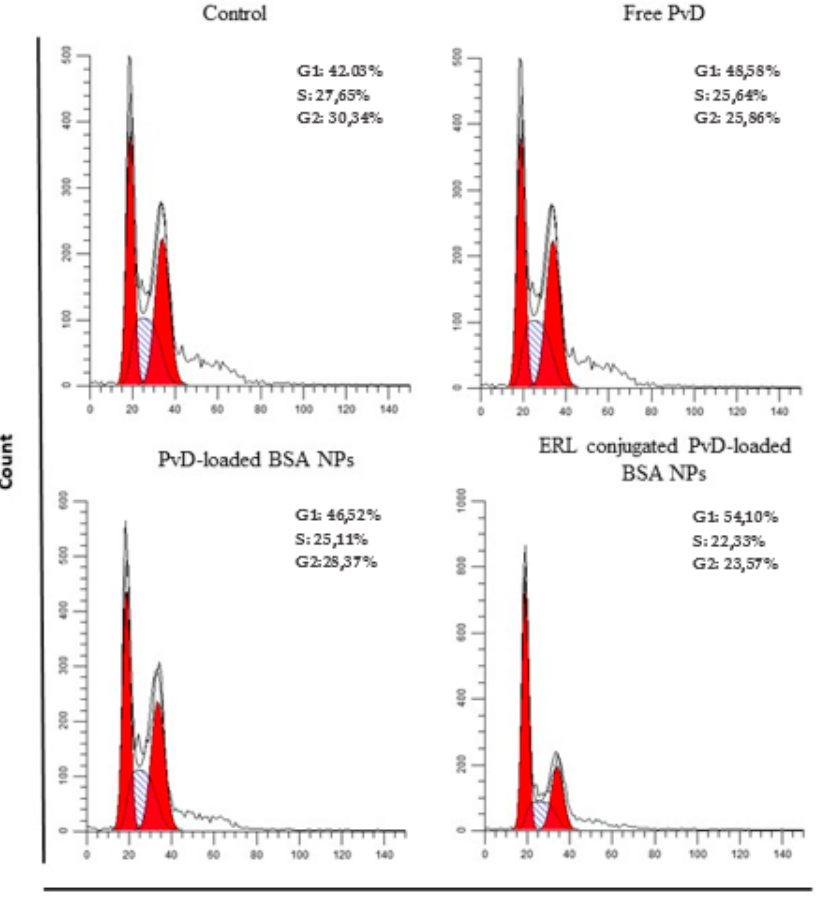
Figure 13. E ff ect of NPs on tumour cell cycle progression. Cellular DNA was stained with propidium iodide (PI) to determine cell cycle distribution. BxPC3 cells were treated with free PvD, PvD-loaded BSA NPs and ERL conjugated PvD-loaded BSA NPs, and compared with control, 24 h after incubation.